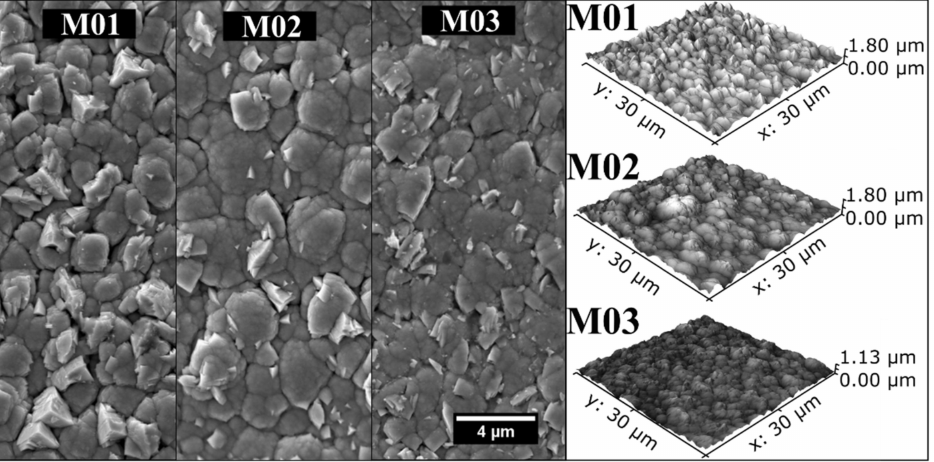
Figure 4. The top surface characterization of the M01, M02, and M03 multilayers by sec- ondary electron FE-SEM imaging and AFM revealed a mix of angular and rounded grains for all deposition conditions.